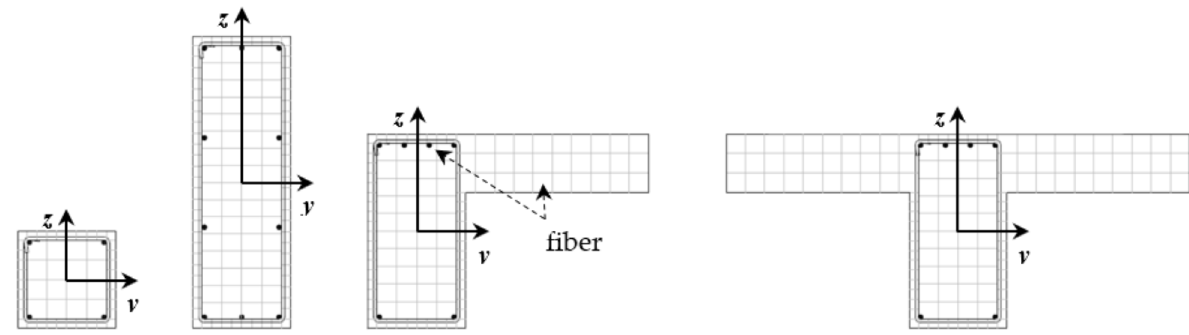
Figure 2. Simulation of the inelastic flexural response of R/C columns and beams using fiber discretization of